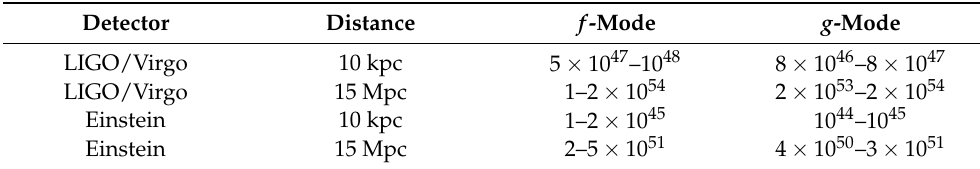
Table 2. The minimum estimated energy (in ergs) required in each mode in order to lead to a detection with signal-to-noise ratio of S / N = 8 from a pulsating slow-stable hybrid star at different distances (local event or at the distance of the Virgo cluster). The results were obtained in Reference [71] using for hadronic matter an EOS based on nuclear interactions derived from chiral effective field theory and for quark matter a generic MIT bag model